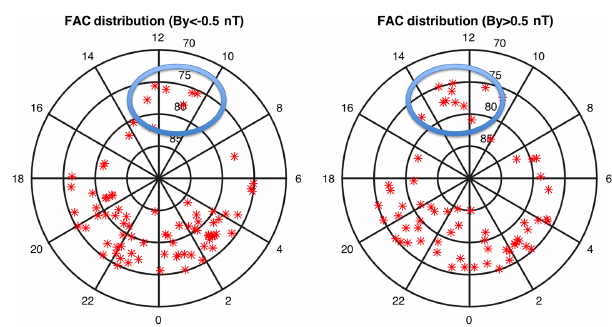
Figure 3. Distribution of polar cap FAC events showing signifi- cant difference between single- and dual-satellite estimates. Events in the cusp region (encircled) are not considered in the